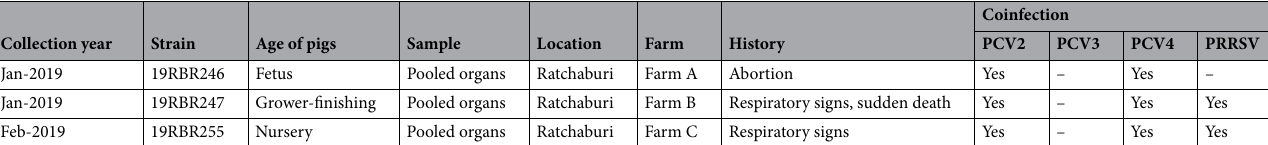
Table 1. PCV4-positive samples found in Thailand during